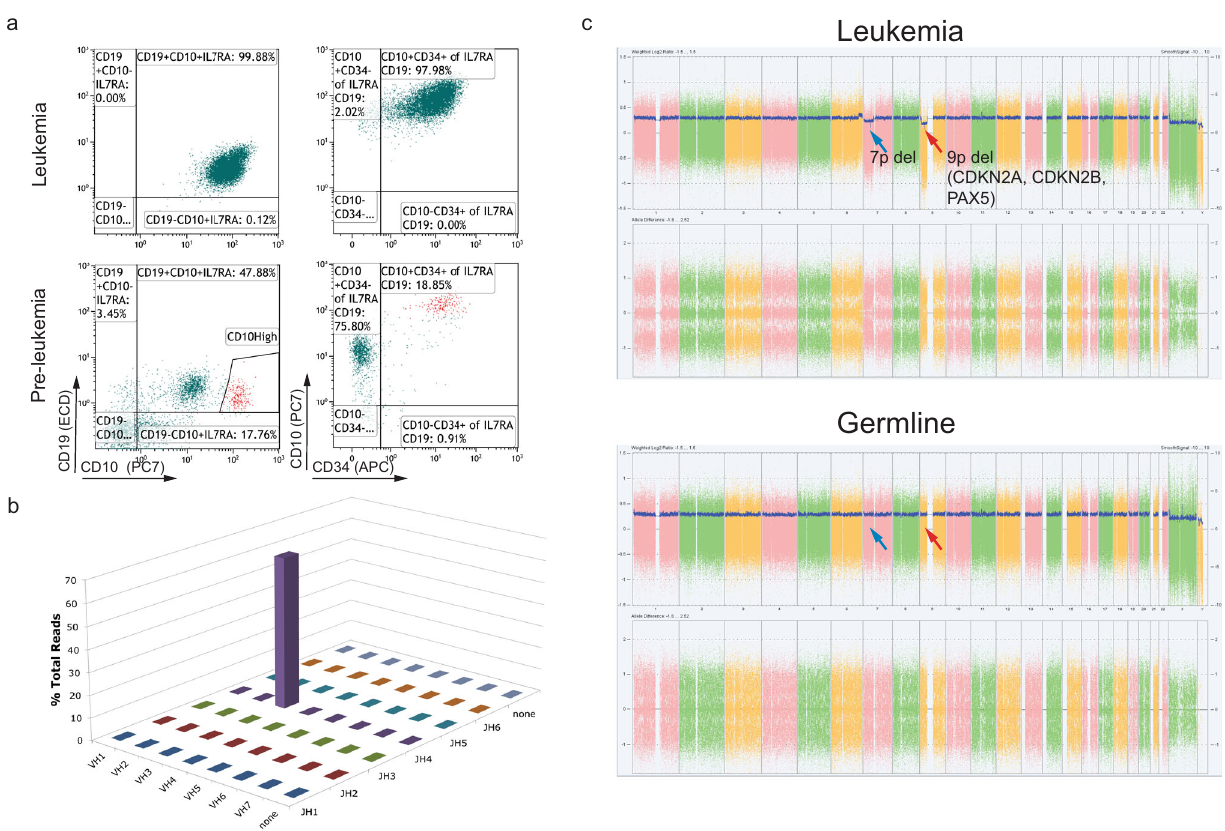
Fig. 3 Secondary transplantation of IL7RA-activated human hematopoietic progenitors result in the development of clonal B-cell precursor leukemia. a Flow cytometer scatter plot of human-engrafted cells in BM of the leukemic mouse. b Bar-graph of V – J rearrangements in leukemic population. The bars represent counts in the sequenced library of B-cell receptor rearrangements. Source data are provided as a Source Data fi le. c Genomic SNP array analysis of leukemic cells (Leukemia) and of BB-transduced engrafted cells from the corresponding cord blood (representing